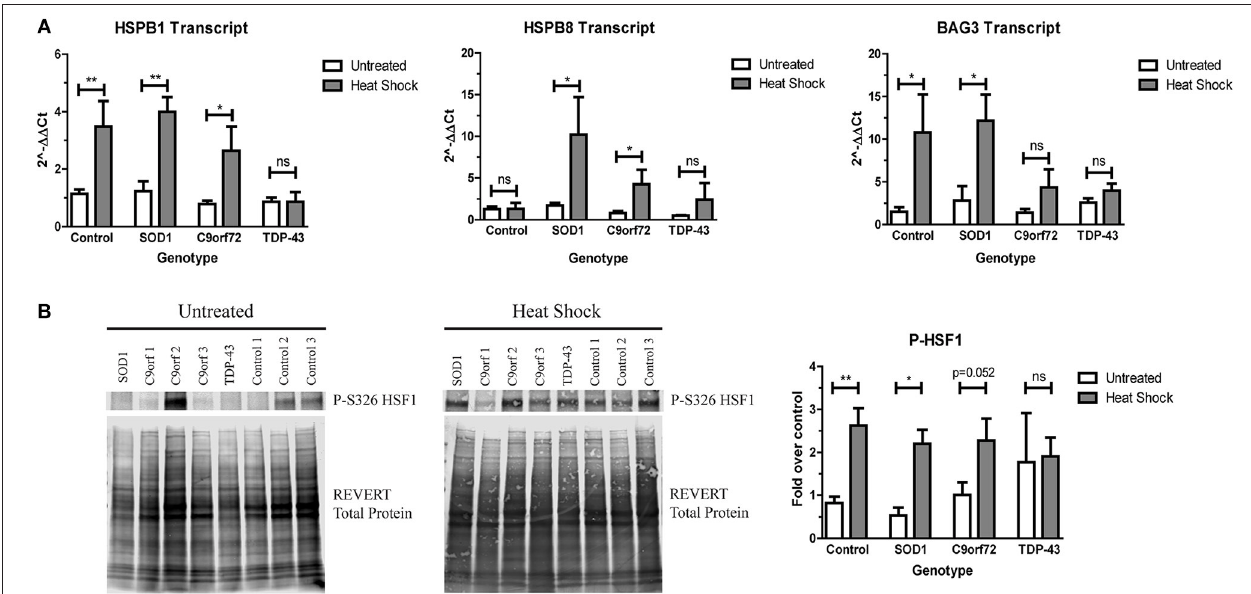
FIGURE 6 | SOD1 and C9orf72 motor neurons induce the HSR after acute heat stress. (A) SOD1 and C9orf72 motor neurons have increased transcript levels of HspB1, HspB8, and BAG3 compared to their untreated samples after 1h of heat shock. Data are normalized to untreated controls (** p < 0.01, * p < 0.05 by Student’s t -test). n = 3–4. (B) Western blot for phosphorylated HSF1 at S326 shows a significant induction in the HSR in control and SOD1 motor neuron cultures compared to their untreated samples after 1h of heat shock. Untreated western blot from Figure 5D is shown again for ease of comparison. Data are normalized to REVERT total protein stain and expressed as a fold change over untreated control samples. (** p < 0.01, * p < 0.05 by Student’s t -test). n =